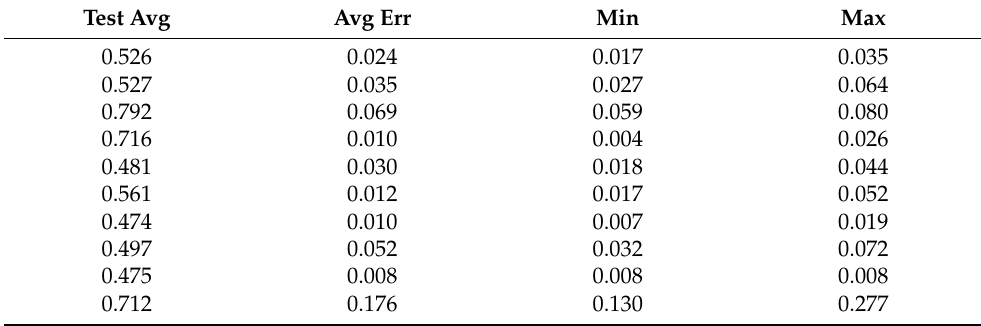
Table A68. Set 1, trials 41–50 data (actual PR value).